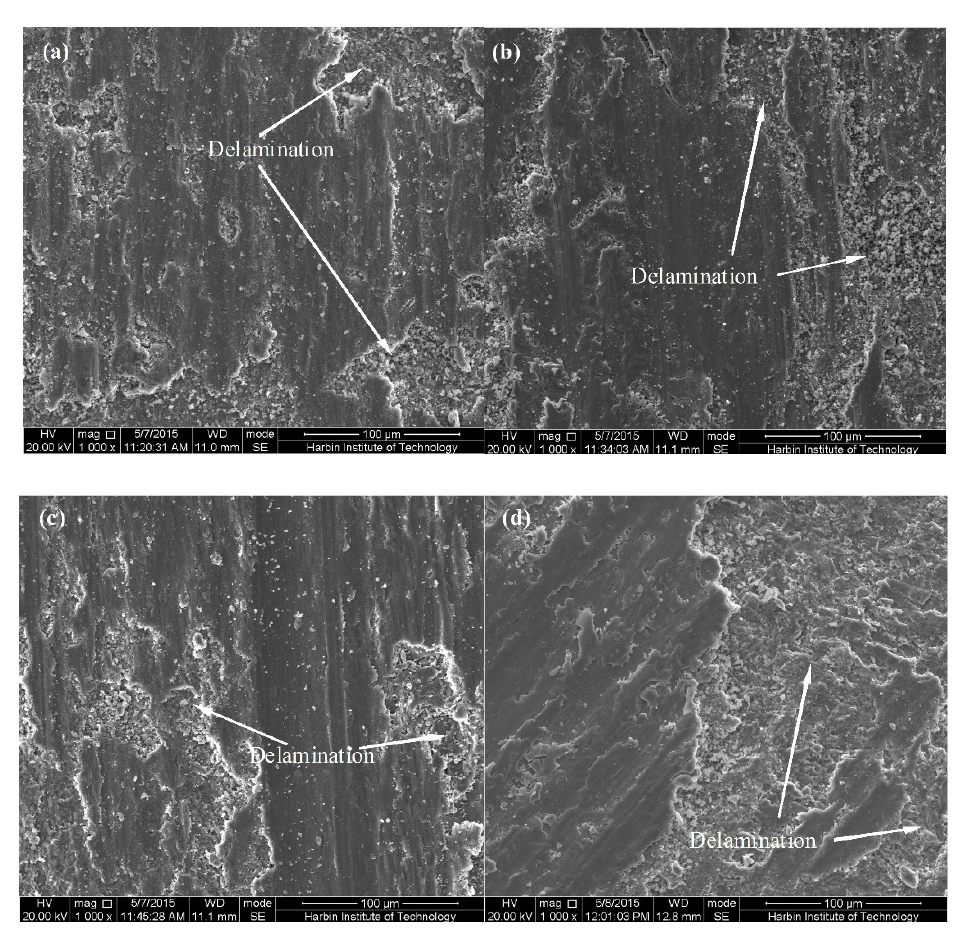
Figure 10. Worn surface morphology of the thixoformed composite parts at different applied load: ( a ) 20 N, ( b ) 30 N, ( c ) 40 N and ( d ) 50 N.